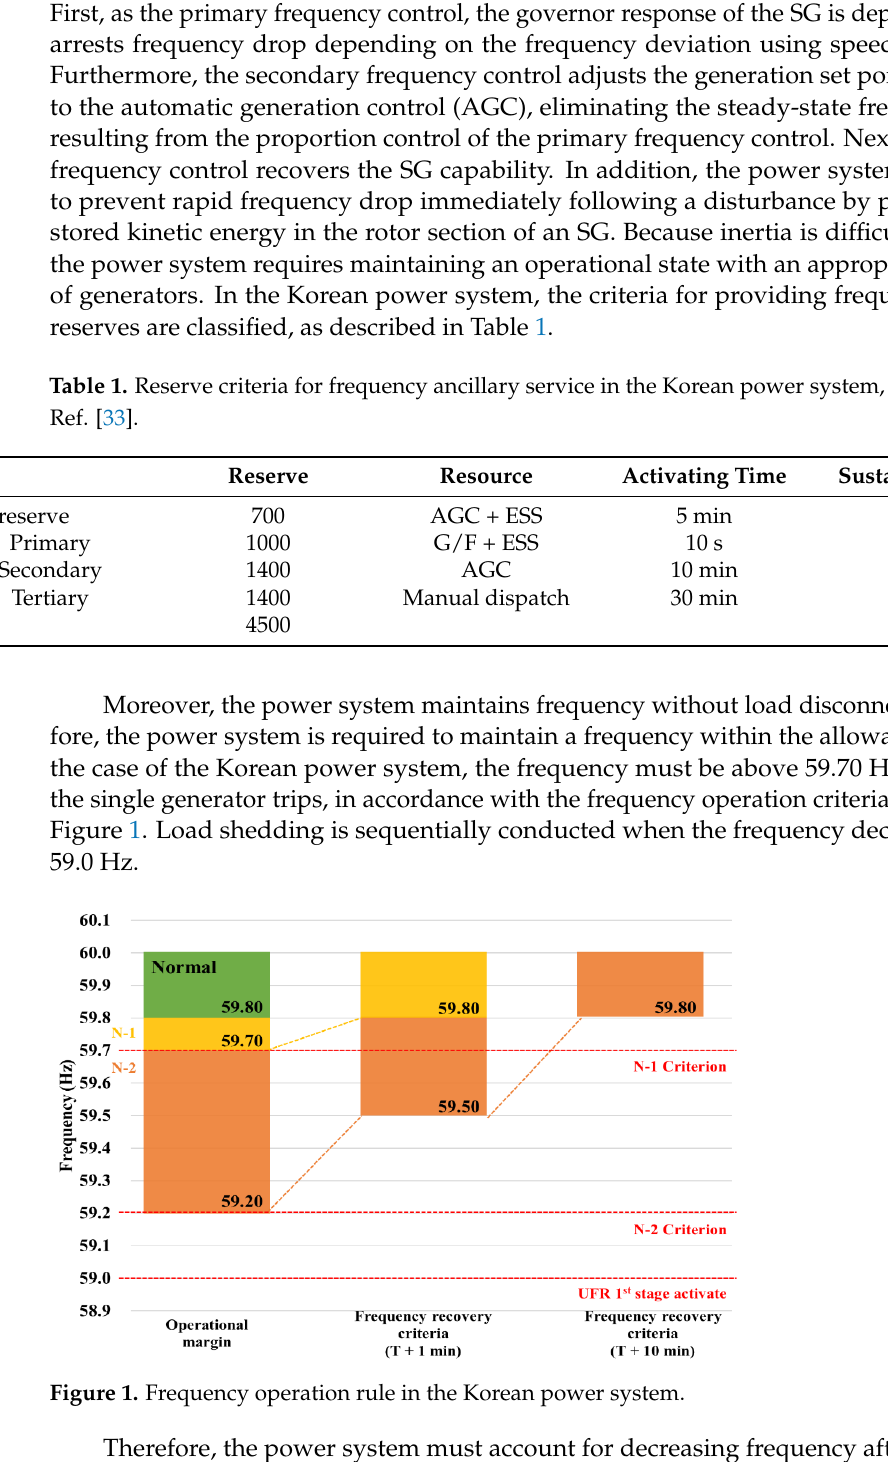
Figure 1. Frequency operation rule in the Korean power system.